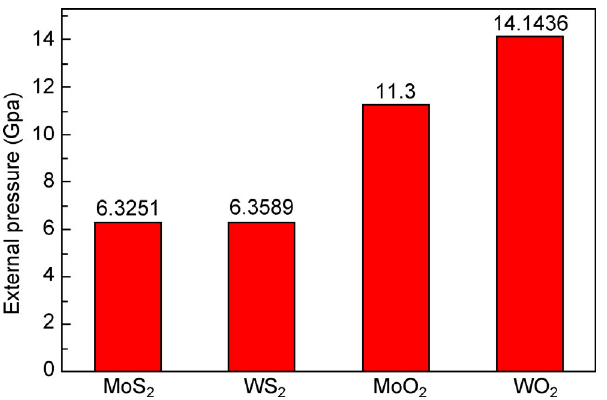
Fig. A2 The normal load is necessary to compress inter-layer distance down by 0.5